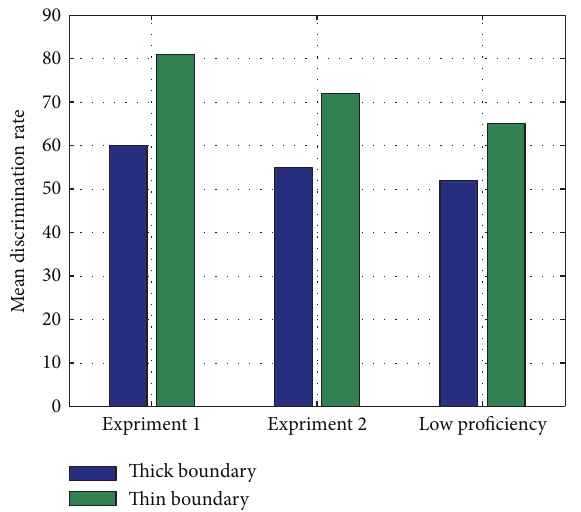
Figure 2: Comparison of thick-boundary speakers’ (blue) and thin- boundary speakers’ (green) perceptual accuracy in distinguish- ing purely nonnative (Experiment 1, left) and L2 (Experiment 2, middle) sound category pairs, supplemented with data from low proficiency speakers (right).